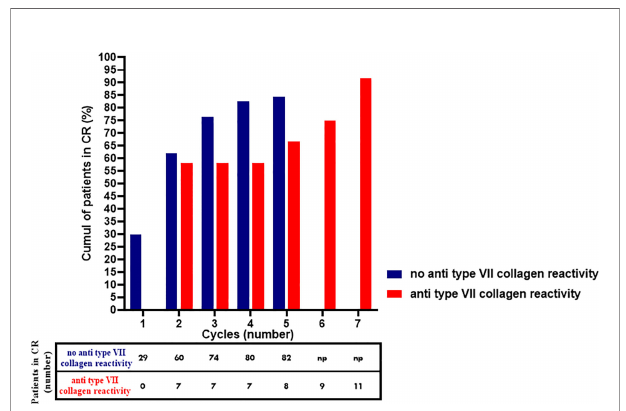
FIGURE 5 | Cumulative proportion of patients with MMP with anti-type VII collagen reactivity MMP without anti-type VII collagen reactivity that achieved complete remission with rituximab. np, no RTX cycle